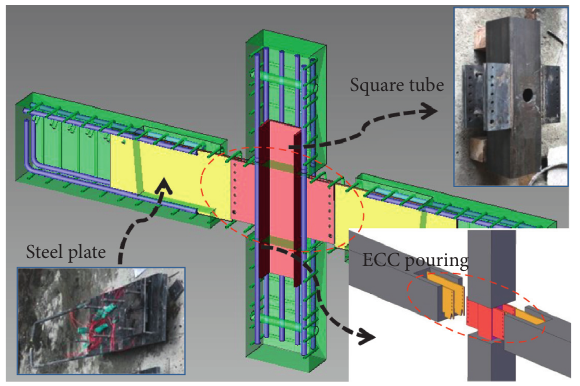
Figure 1: Description of development of precast concrete beam-to- column